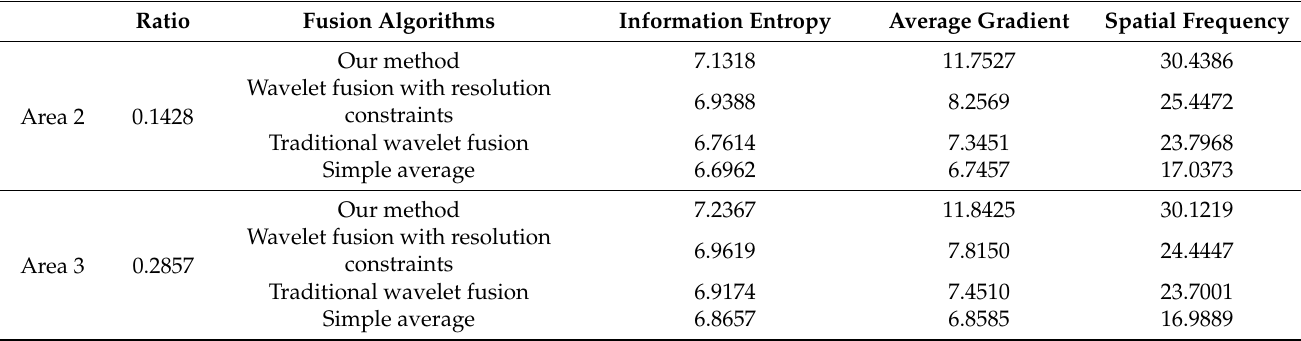
Figure 9. ( a ) shows the strip images and fusion strip images in Area 2. ( b ) shows the strip images and fusion strip images in Area 3. Table 5. Comparison of fusion results of different methods in Areas 2 and